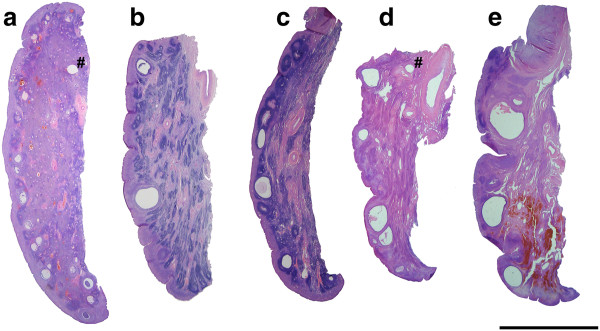
 Photographs of 25 μm thick sections through the ovaries of prepubertal African elephant calves (Scale bar = 10 mm).a) At 2 months of age, abundant interstitial tissue is visible within the medulla. Several small antral follicles are seen on the cortico-medullary border, these are now regarded as being in the cortex even though they may bulge into the medulla. Artifacts marked with a # are pin holes. b) At 1 year of age, the cortical depth is greater than in (a) and isolated larger antral follicles may be seen. Interstitial tissue is present in streaks within the medulla. c) At 1.5 years of age, interstitial tissue is visible within the medulla and antral follicles are observed more frequently than in (b). d) By 3 years of age, the ovary is settling into its adult pattern of antral follicles residing wholly within the true cortex. e) At 4.5 years, the ovary is now starting to enlarge due to a considerable increase in the volume of the cortex.